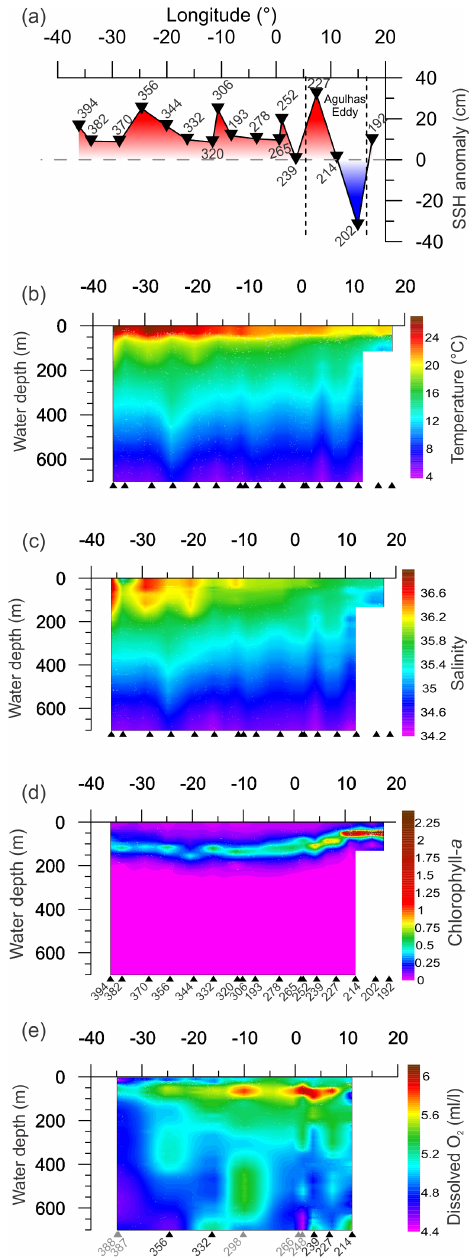
Figure 2. Variation measured in environmental parameters from CTD and satellite for the upper 700m of the water column along the transect. Triangles indicate the location of sampling sites (black tri- angles are sites with multi-net casts, gray triangles are sites without multi-net casts from Karstensen et al, 2016, used for DO gridding). Panels (a) – (c) show gridded values of CTD measured parameters. (d) Satellite sea surface height from SSALTO/DUACS for the re- spective stations sampling days. (e) Dissolved oxygen, the gridding used some stations near to stations with multi-net cast (grey num- bers), as no oxygen data are available (see Table 1 for